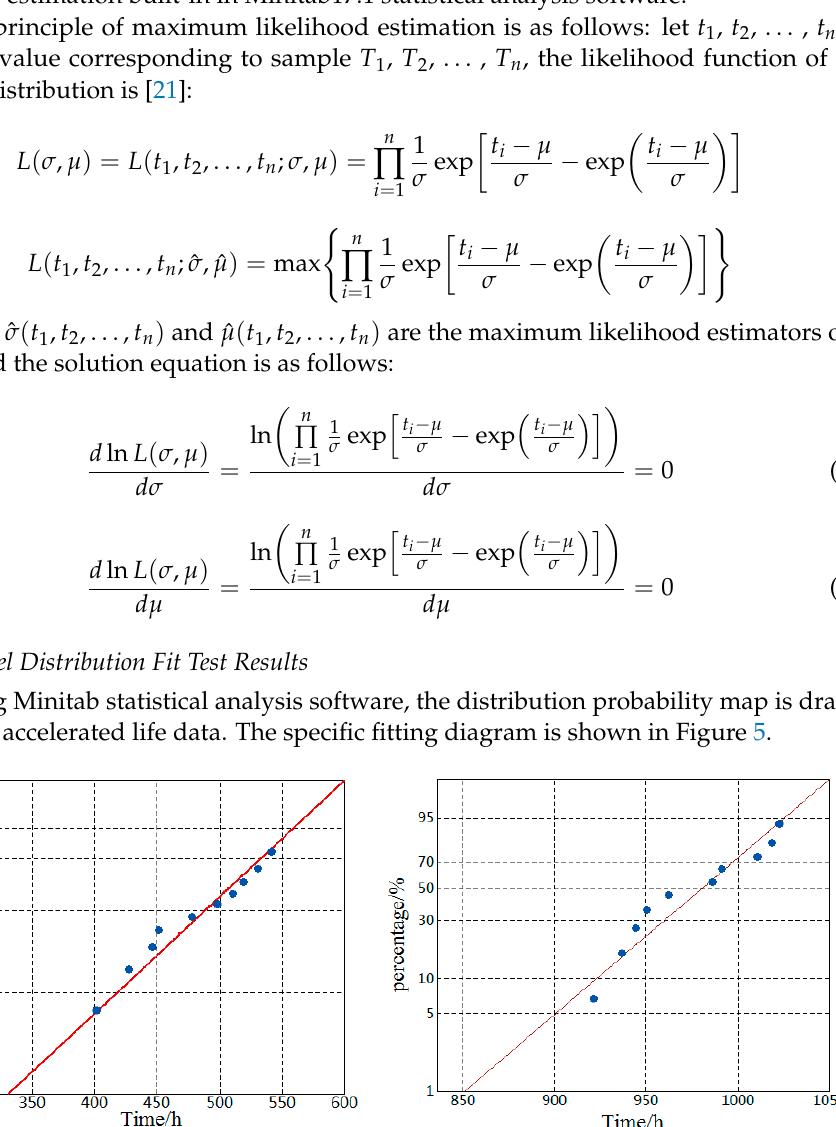
Table 8. Table 8. Test of fi tt ing degree of test piece and result of parameter estimation. Specimen